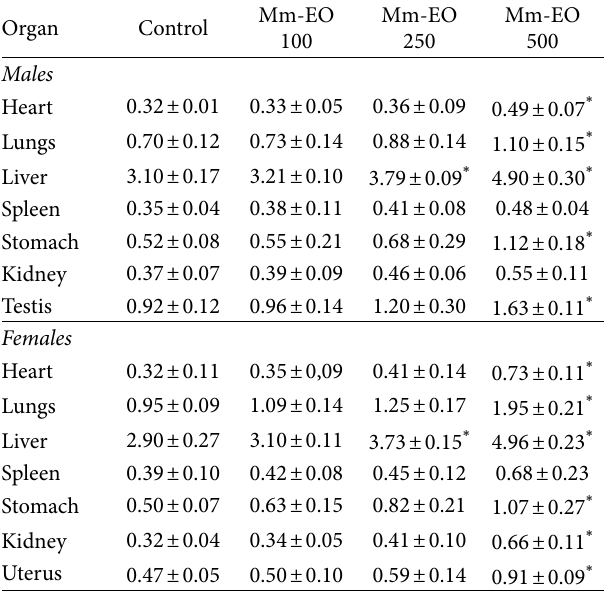
Values are expressed as Mean ± SD, significance when compared with con- trol ∗ ( 𝑝 < 0.05 ). One-way ANOVA followed by Tukey test.